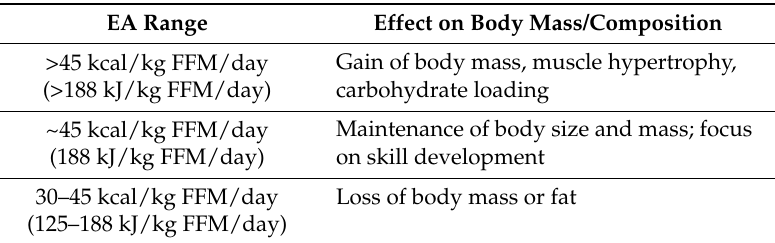
Table 1. Loucks’ proposed energy availability ranges for different athletic functions. Adapted from Loucks, 2013